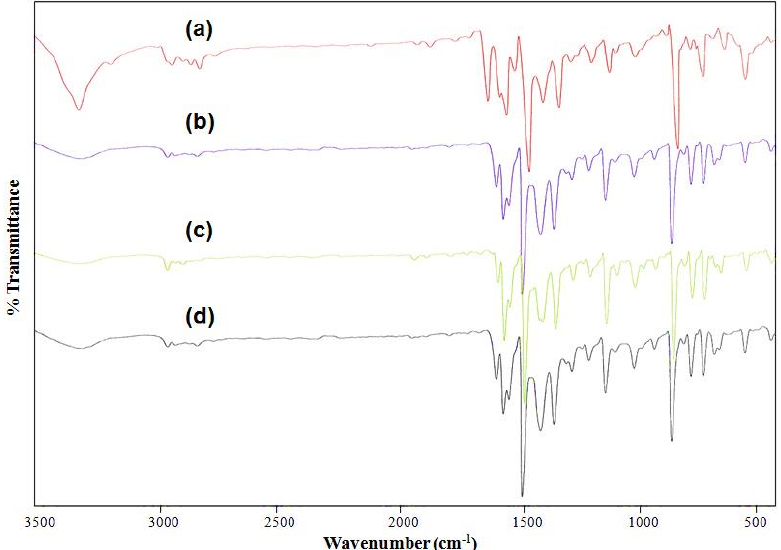
Fig. 1. FT-IR spectra of (a) neocuproine ligand, (b) nanoparticles of compound 1 prepared by sonochemical method, (c) hydrothermal method, and (d) bulk materials as synthesized of 1.